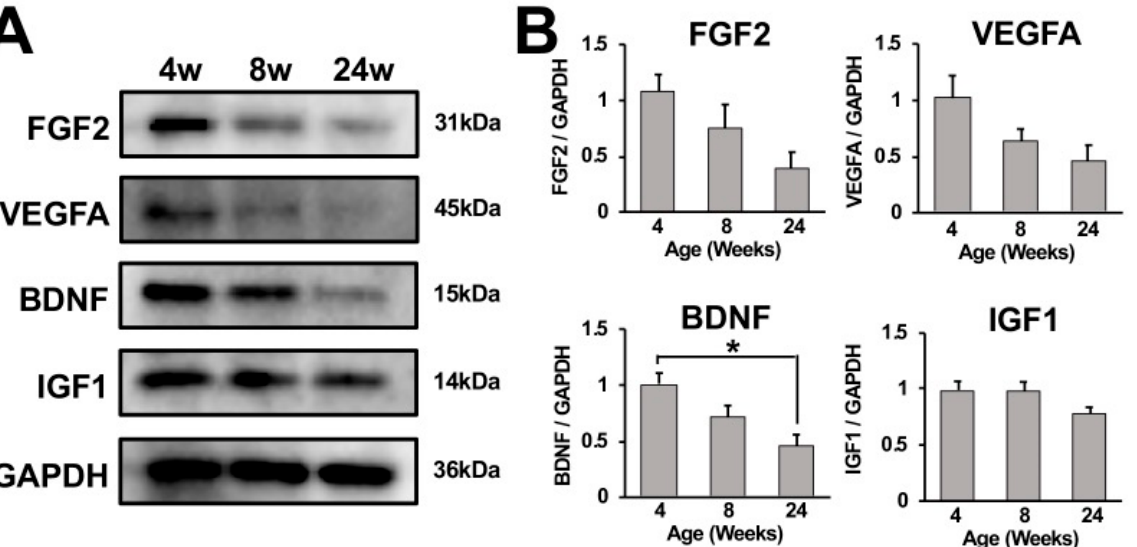
Figure 5. Growth factor expression in the cervical spinal cord. ( A ) Detection of FGF2, VEGFA, BDNF, and IGF1 expressions in the cervical spinal cords of a female rat at 4, 8, and 24 weeks of age using Western blot analysis. Expression of FGF2, VEGFA, and BDNF visually declined as rats grew, whereas a decrease in IGF1 expression was not apparent. ( B ) Quantification of band intensities. Results represent the mean for the relative band intensity values to GAPDH ± SEM (n = 3). The cervical spinal cord of a 4-week-old subject demonstrated significantly higher band intensity of BDNF than that of a 24-week-old subject. * p < 0.05. One-way ANOVA with the Tukey– Kramer test.